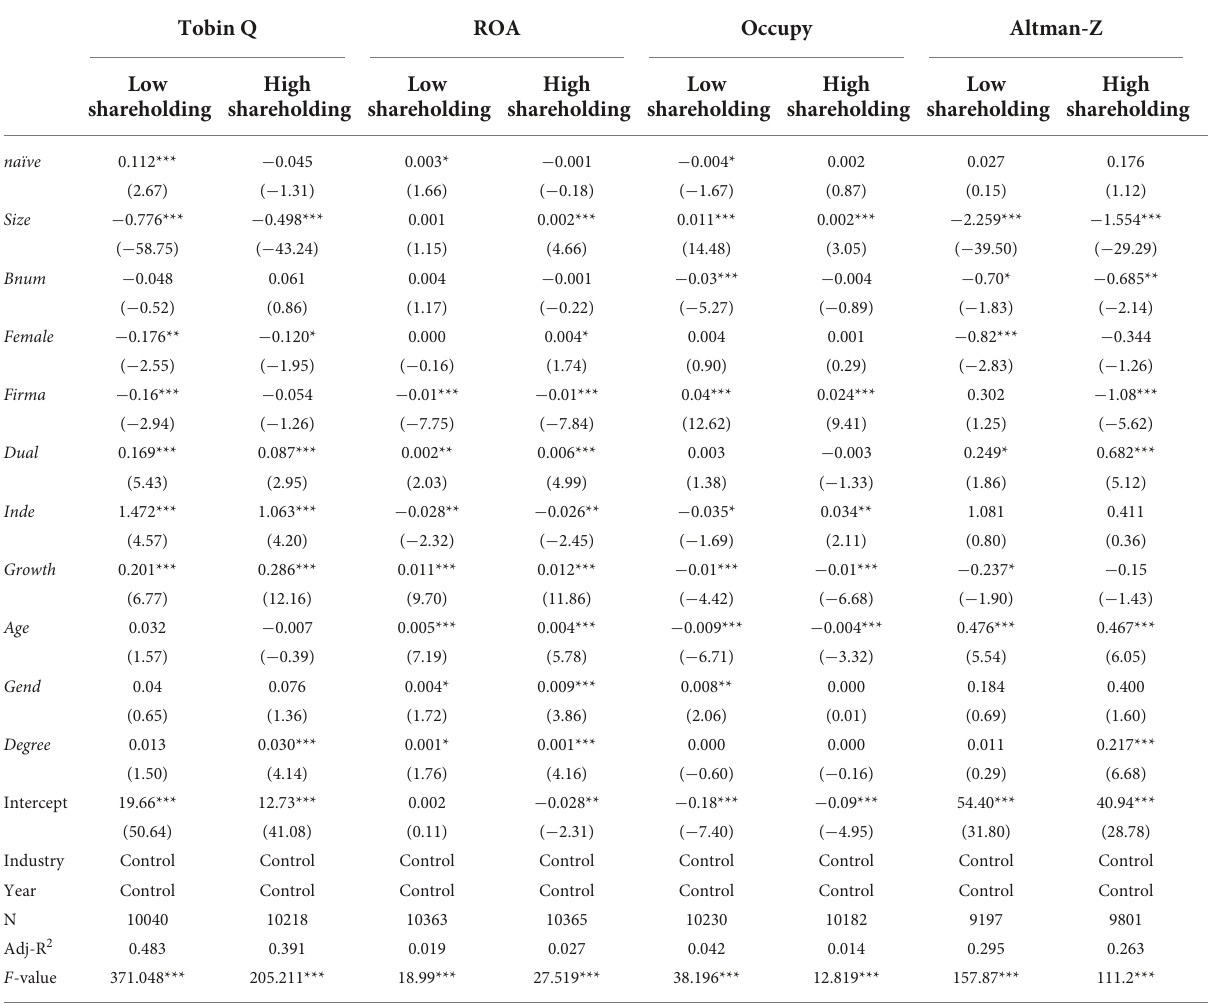
TABLE 9 The effects of the largest shareholders’